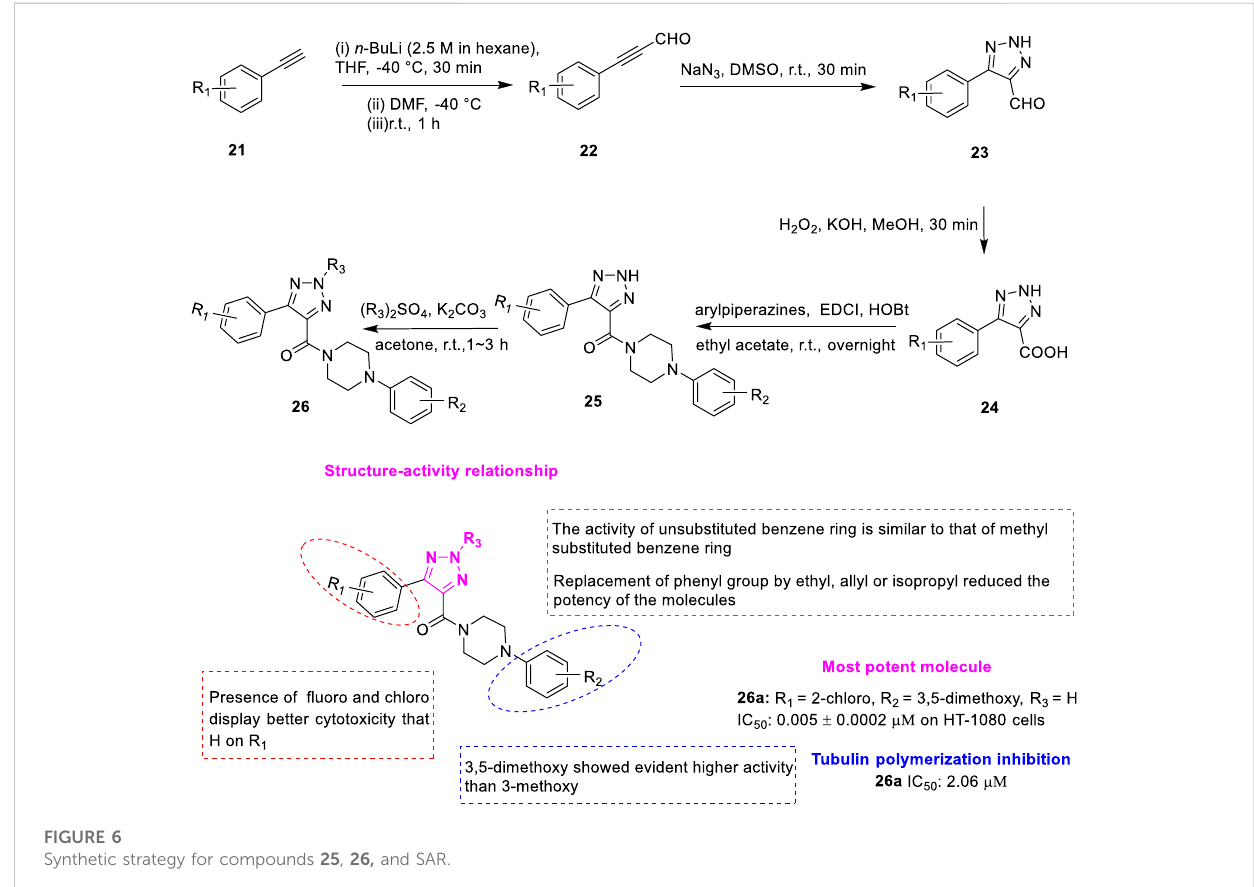
FIGURE 6 Synthetic strategy for compounds 25 , 26, and